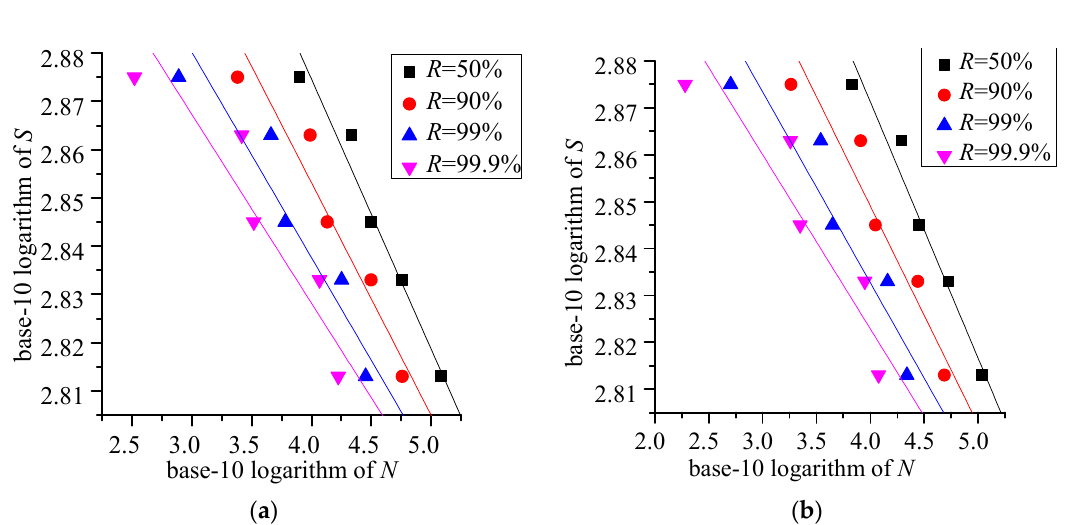
Figure 5. P–S–N curves at tempering temperature 500 ◦ C and confidence levels: ( a ) γ = 95%; ( b ) γ = 99% .